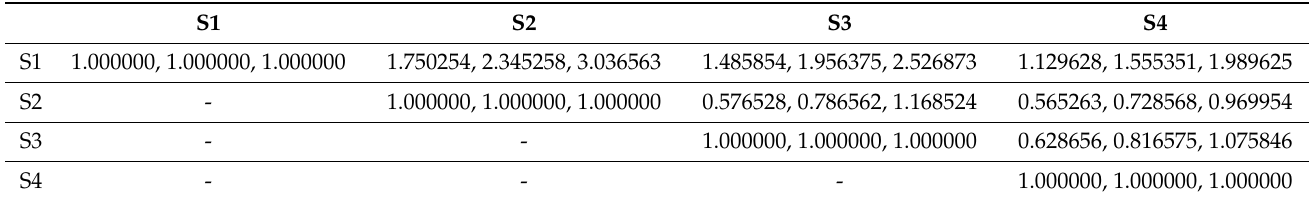
Table 1. The aggregated fuzzify pairwise comparison matrix at Level 1.